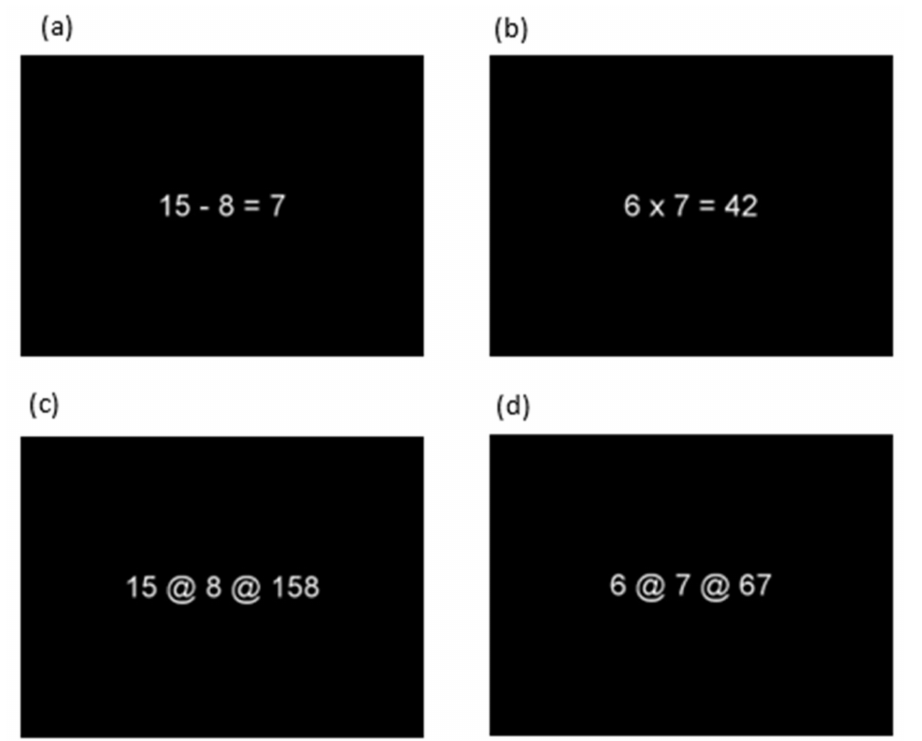
Figure 1. Examples of ( a ) a subtraction trial, ( b ) a multiplication trial, with the corresponding control trials (panels ( c , d